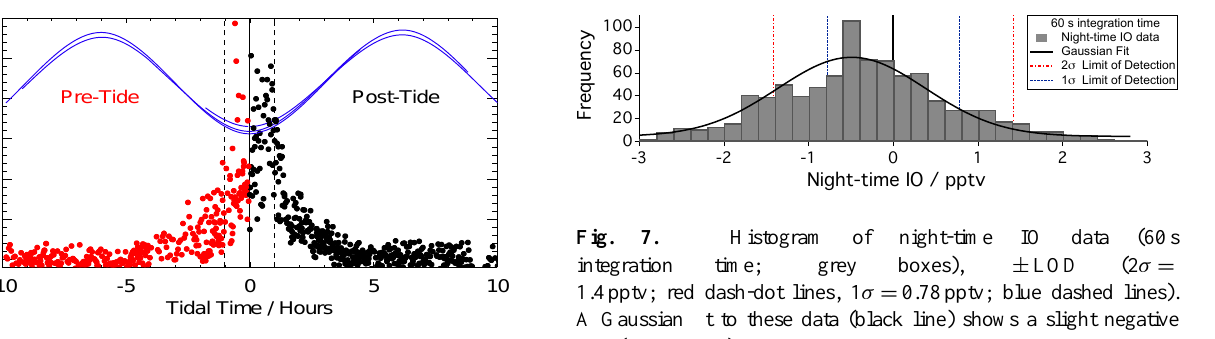
Fig. 6. IO mixing ratio as a function of time from daytime low tide for all data between 28–30 August. Data are separated between before (red) and after (black) daytime low tide. The hour before and after low tide is indicated by black dashed lines.